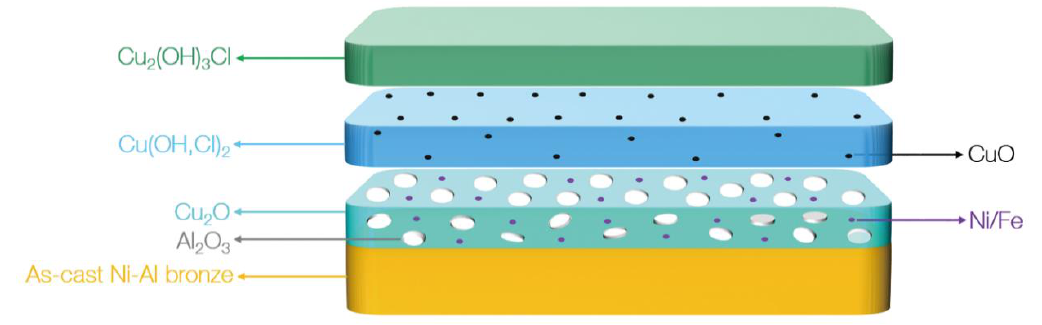
Figure 12. The corrosion product film structure of S-Defect immersed in artificial seawater for a long a long time.